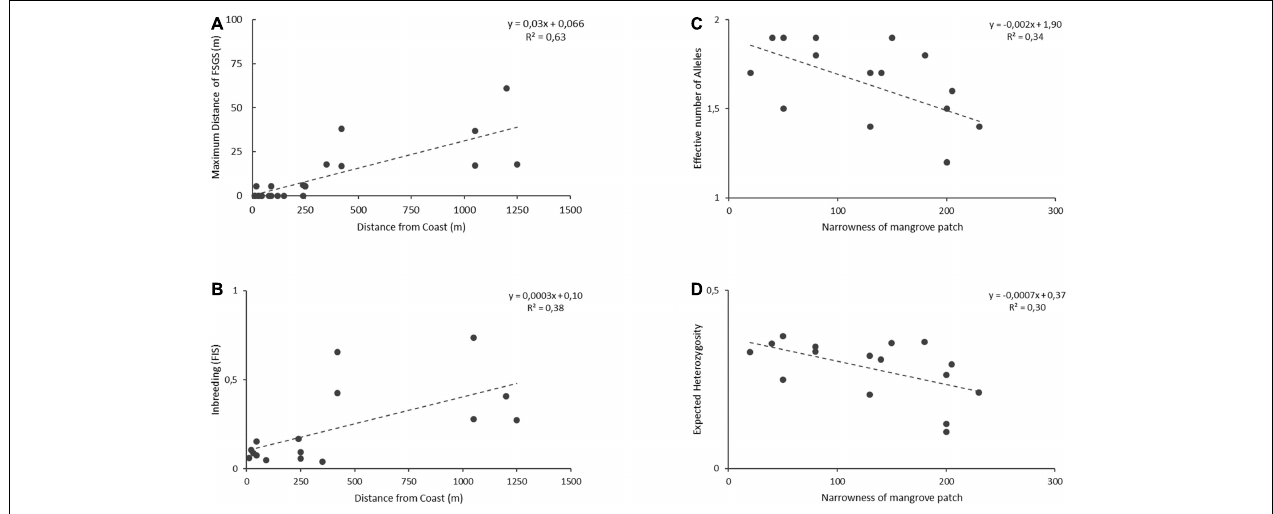
FIGURE 4 | Relationship of the position (distance to coastline) of Avicennia populations ( N = 24) and (A) the extent of their fine-scale genetic structure, (B) the within-population inbreeding ( F IS ). Association between the narrowness of a mangrove patch, and (C) effective number of alleles and (D) expected